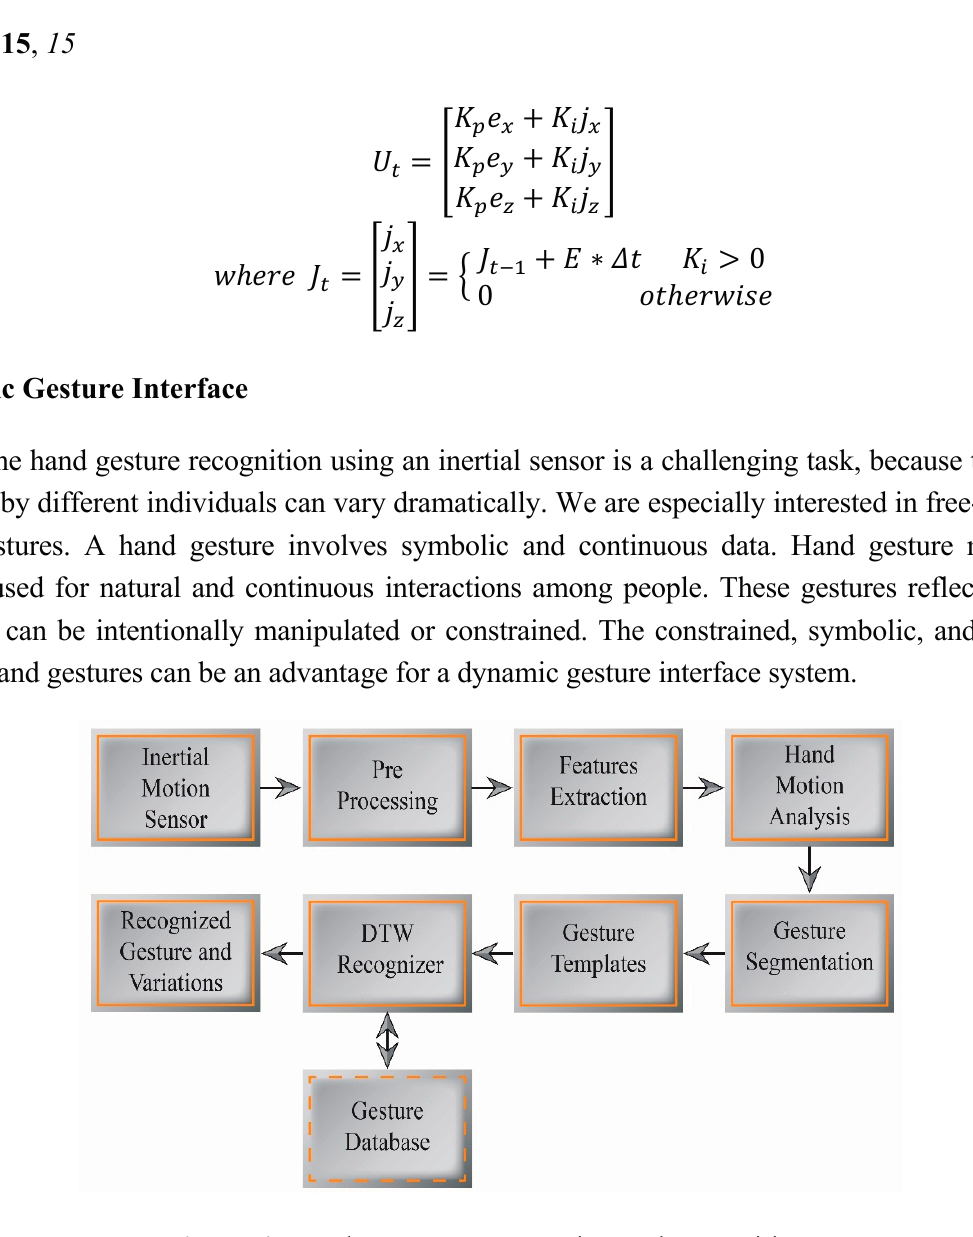
Figure 4. Hand gesture segmentation and